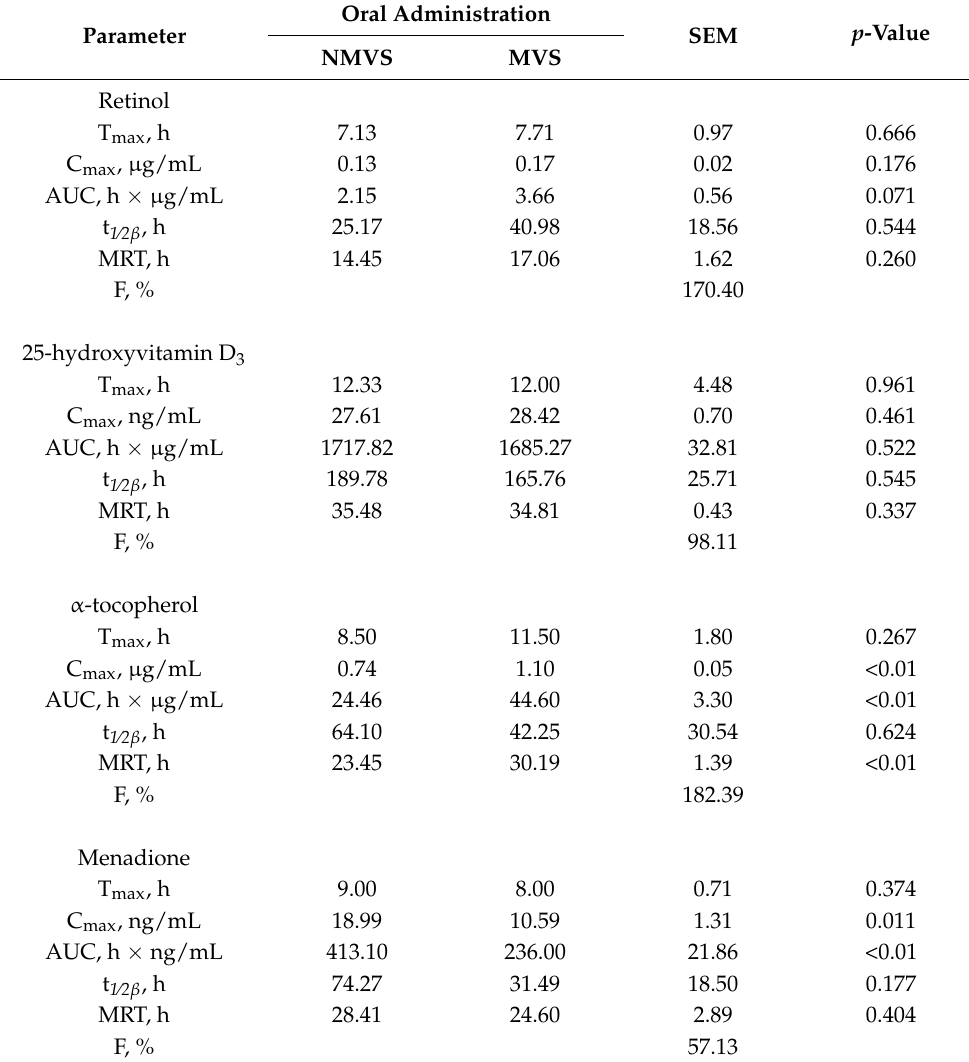
Table 2. Pharmacokinetic parameters of plasma fat-soluble vitamin concentrations in pigs 1